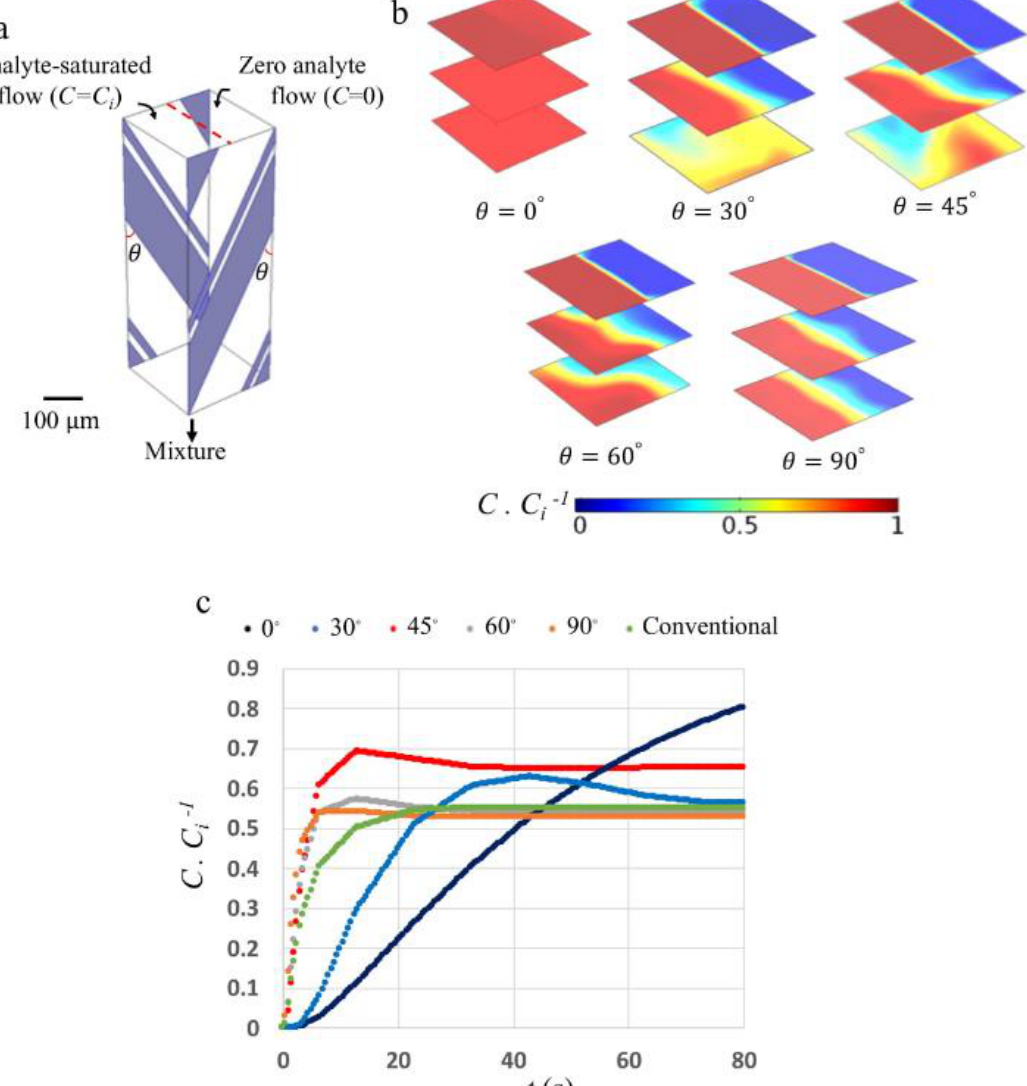
Figure 5. ( a ) shows the geometry of the microfluidic channel with the microelectrodes placed at an angle of θ . Two flows, one of which has an analyte concentration of C i = 10 − 7 mol · m − 3 , are mixed and pumped due to the ACET effect. To save computational time, only a portion of the microfluidic channel, covering one electrode pair with periodic boundary conditions at the two ends (i.e., inlet and outlet) of the channel, is modeled. ( b ) shows the steady-state concentration distribution at three different cross-sectional surfaces separated by an equal distance of 150 µ m for 5 different microelectrode angles. At θ = 0 ◦ , the device becomes a pure micromixer, whereas, at θ = 90 ◦ , the device acts as a micropump. ( c ) shows the outlet dimensionless concentration versus time. For θ ≥ 45 ◦ (red, grey, and orange lines), a rapid increase in concentration occurs within 8 s, whereas, for θ < 45 ◦ (blue and dark blue lines), concentration changes occur over a longer period of time. The results of a conventional single-array ACET device, which typically has an electrode angle of θ = 90 ◦ (green line), are included for